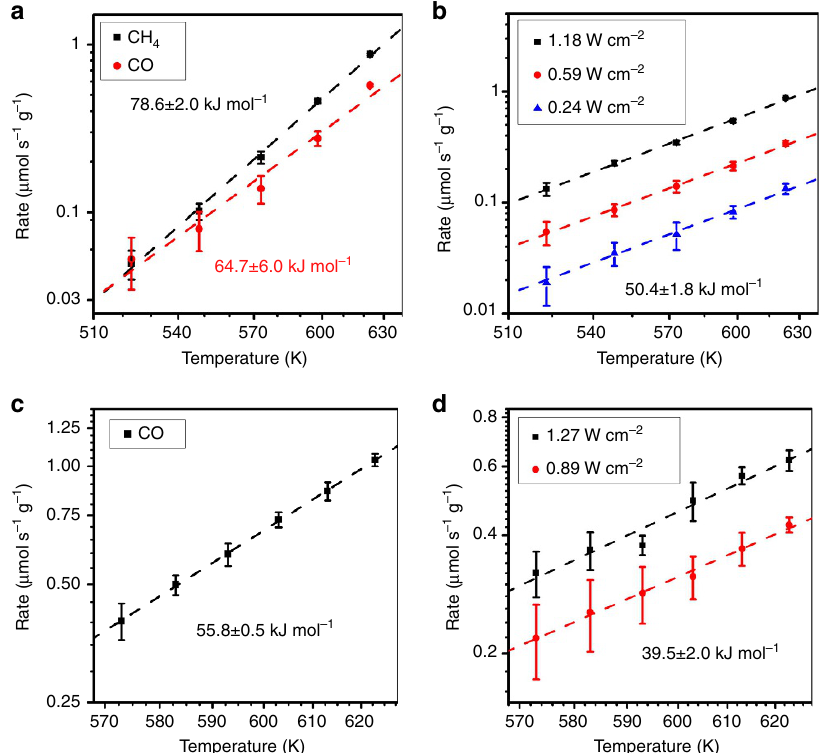
Figure 3 | Apparent activation energies on the rhodium and gold photocatalysts. ( a ) Thermocatalytic reaction rates of CH 4 (black squares) and CO (red circles) production on Rh/Al 2 O 3 as a function of temperature. The apparent activation energies are obtained by fitting the results with an Arrhenius equation. ( b ) Photoreaction rates for CH 4 production on Rh/Al 2 O 3 under 1.18 (black squares), 0.59 (red circles) and 0.24Wcm (cid:2) 2 (blue triangles) ultraviolet illumination as a function of temperature. The photocatalytic reactions show the same apparent activation energy, which is lower than that of thermocatalytic reaction. ( c ) Thermocatalytic reaction rates of CO production on Au/Al 2 O 3 as a function of temperature. ( d ) Photoreaction rates of CO production on Au/Al 2 O 3 under 1.27 (black squares) and 0.89Wcm (cid:2) 2 (red circles) white light as a function of temperature. Reduced apparent activation energies of photoreactions are observed on both Rh and Au photocatalysts, but with different selectivity. Error bars represent the s.d. of measurements by the mass